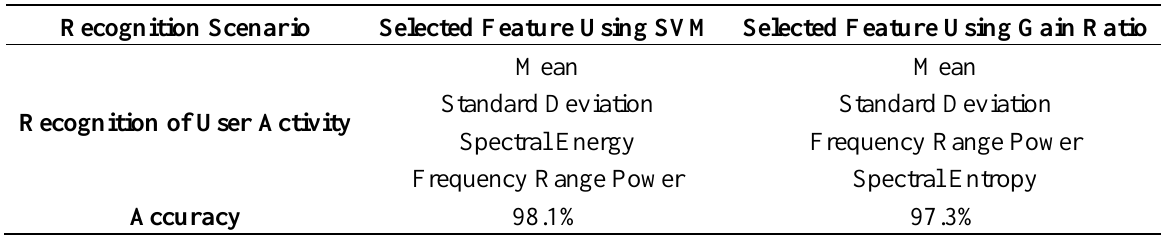
Table 4. Selected feature using SVM and gain-ratio feature evaluator and their corresponding recognition accuracy (Classifier: